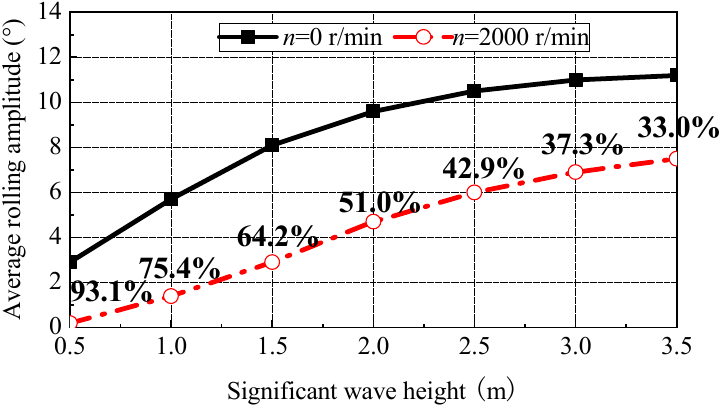
Figure 12. Average roll amplitude of the ship and average anti-roll rate for varying significant wave heights.